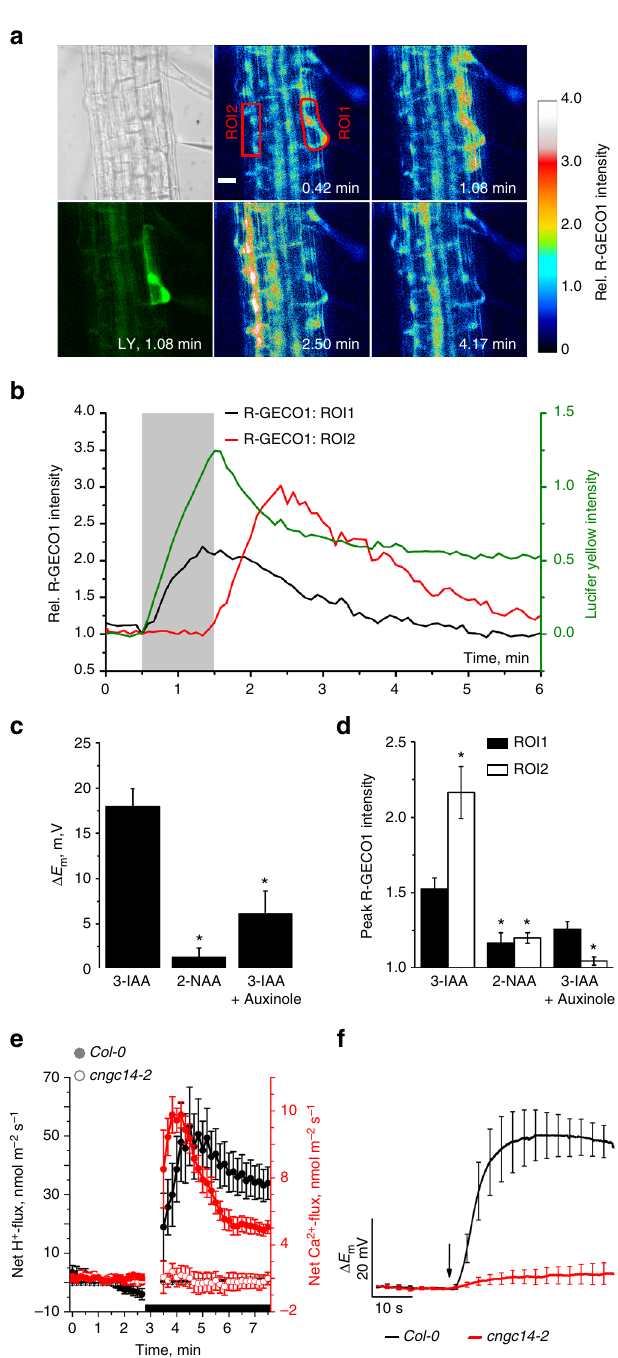
Fig. 5 Cytosolic application of IAA triggers a lateral Ca 2 + wave in roots. a IAA was applied iontophoretically together with Lucifer yellow (LY) via an intracellular double-barreled microelectrode. Panel upper left, transmitted light signal, note microelectrode on right. Panel lower left, LY fl uorescence signal at indicated time value. Panels middle and right, false color images of R-GECO1 intensity, normalized to the average value of ROI1 just before stimulation with IAA, as indicated by the scale on left. Time after experiment onset is given. IAA was injected with a current of -1 nA to the cell in ROI1, from t = 0.5 to 1.5 min. Representative measurement from 20 experiments. The scale bar represents 20 µ m. b Representative time- dependent changes in the fl uorescence signal of LY (green line, right axis) and the R-GECO1 signals of ROI1 (black line, left axis) and ROI2 (red line, left axis), relative to their average fl uorescence intensity at the start of injection. The light gray bar indicates the period of iontophoretic injection of IAA. Representative measurement from 20 experiments. c , d Responses of A . thaliana Col-0 root-hair cells to iontophoretical intracellular injection of IAA, 2-NAA, and IAA in roots pretreated with 20 µ M auxinole. c Average value of max. depolarization. d Average changes in R-GECO1 signals of ROI1 (closed bars) and ROI2 (open bars, n = 20 ± s.e.m. for IAA; n = 11 ± s.e.m. for 2-NAA and n = 6 ± s.e.m. for IAA w/auxinole), asterisks indicate signi fi cant differences (Students t -test, p < 0.05). e Average net Ca 2 + - (red) and H + - (black) fl ux kinetics of wild-type (closed symbols) and cngc14-2 (open symbols) roots. After 3 min, IAA was applied to a fi nal concentration of 10 µ M (black bar), curves are interrupted at time point of IAA stimulation, n = 17 ± s.e.m. for Col-0 Ca 2 + - fl uxes, n = 18 ± s.e.m. for cngc14-2 Ca 2 + - fl uxes, n = 7 ± s.e.m. for H + - fl uxes. f IAA-dependent changes in the membrane potential of wild-type and cngc14-2 mutant root hairs. Average traces of A . thaliana Col-0 (black) and of the cngc14-2 (red) mutant following a 1 s stimulation with 10 µ M IAA (arrow) ( n = 6 ± s.e.m. for Col-0 and n = 7 ± s.e.m. for cngc14-2